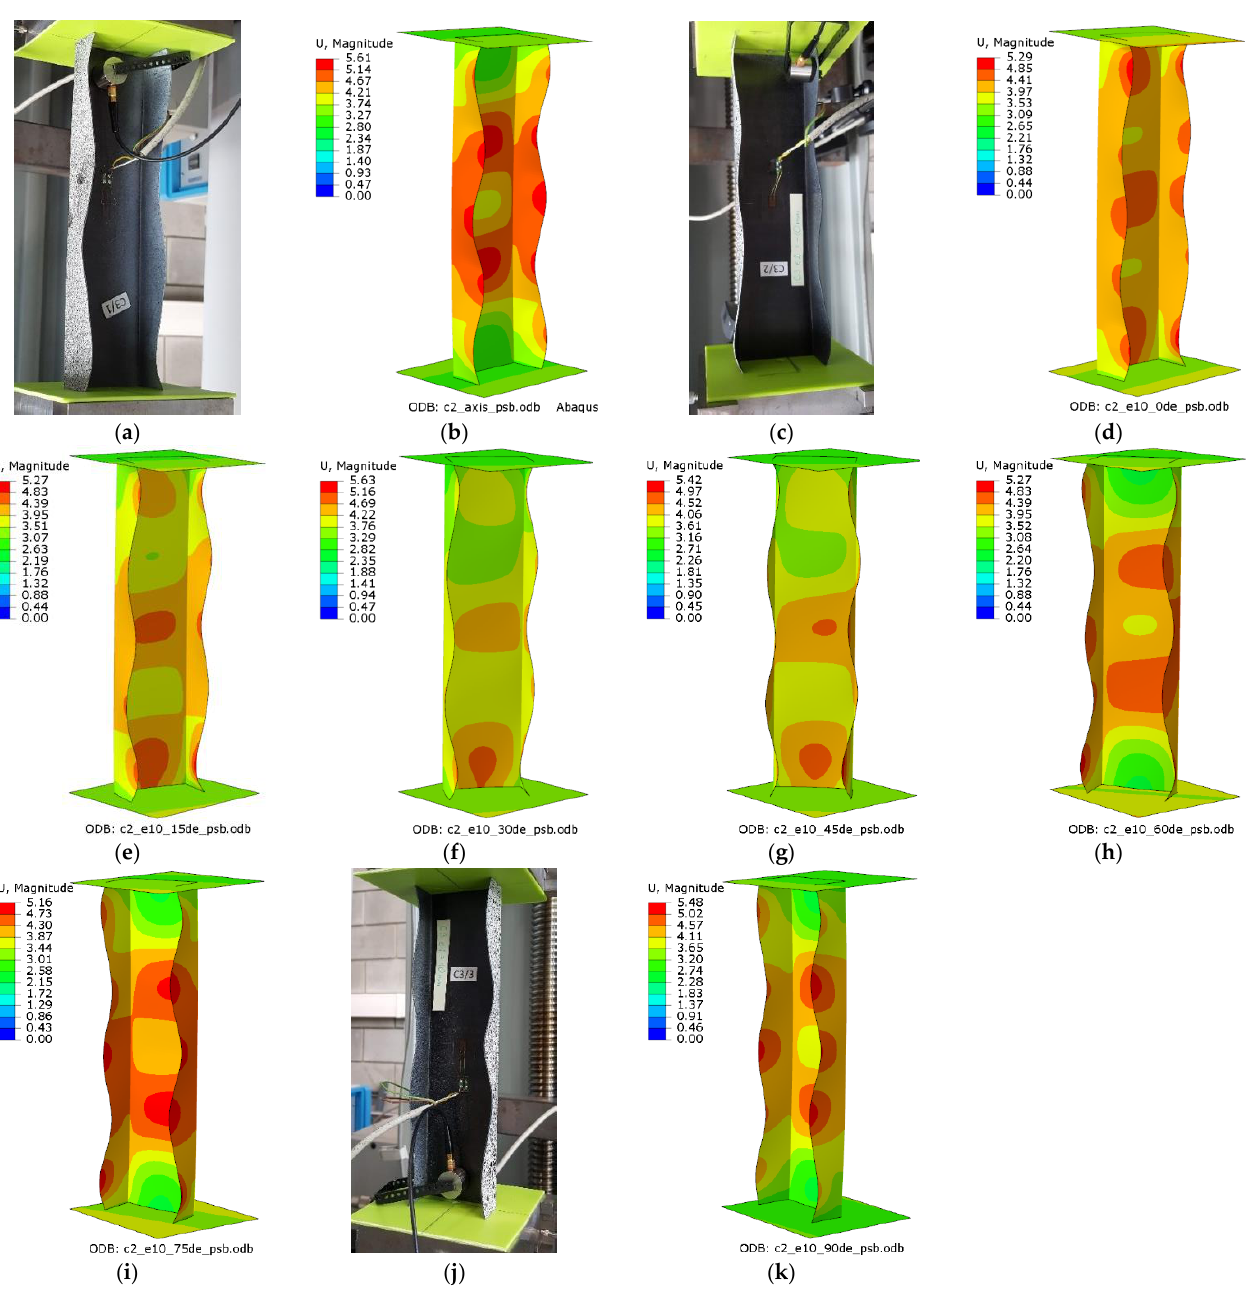
Figure 17. Early postbuckling modes for C2 [90/ − 45/45/0] s : ( a ) axis EXP, ( b ) axis FEM, ( c ) e10_0° EXP, ( d ) e10_0° FEM, ( e ) e10_15° FEM, ( f ) e10_30° FEM, ( g ) e10_45° FEM, ( h ) e10_60° FEM, ( i ) e10_75° FEM, ( j ) e10_90° EXP, ( k ) e10_90° FEM.